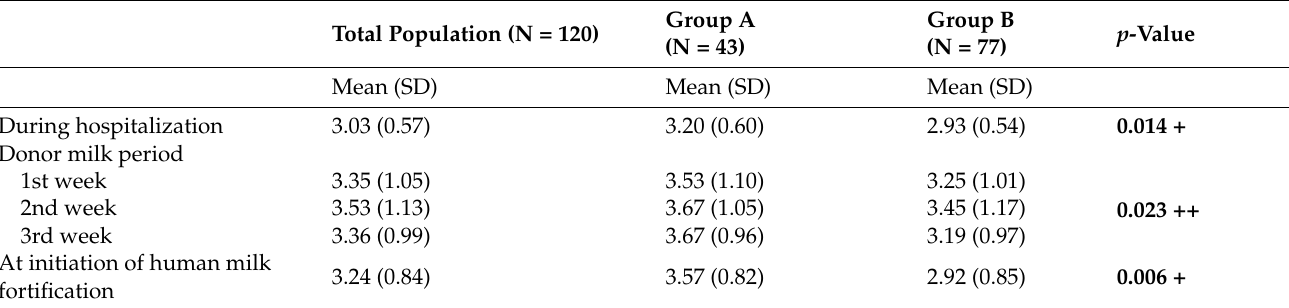
Table 3. Protein intake (g/kg/day) of the study